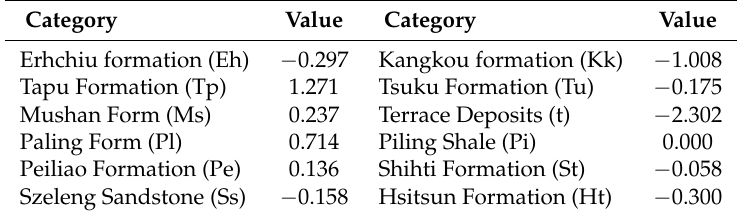
Table 2. Regression values for the categorical variable of geo in terms of different lithological